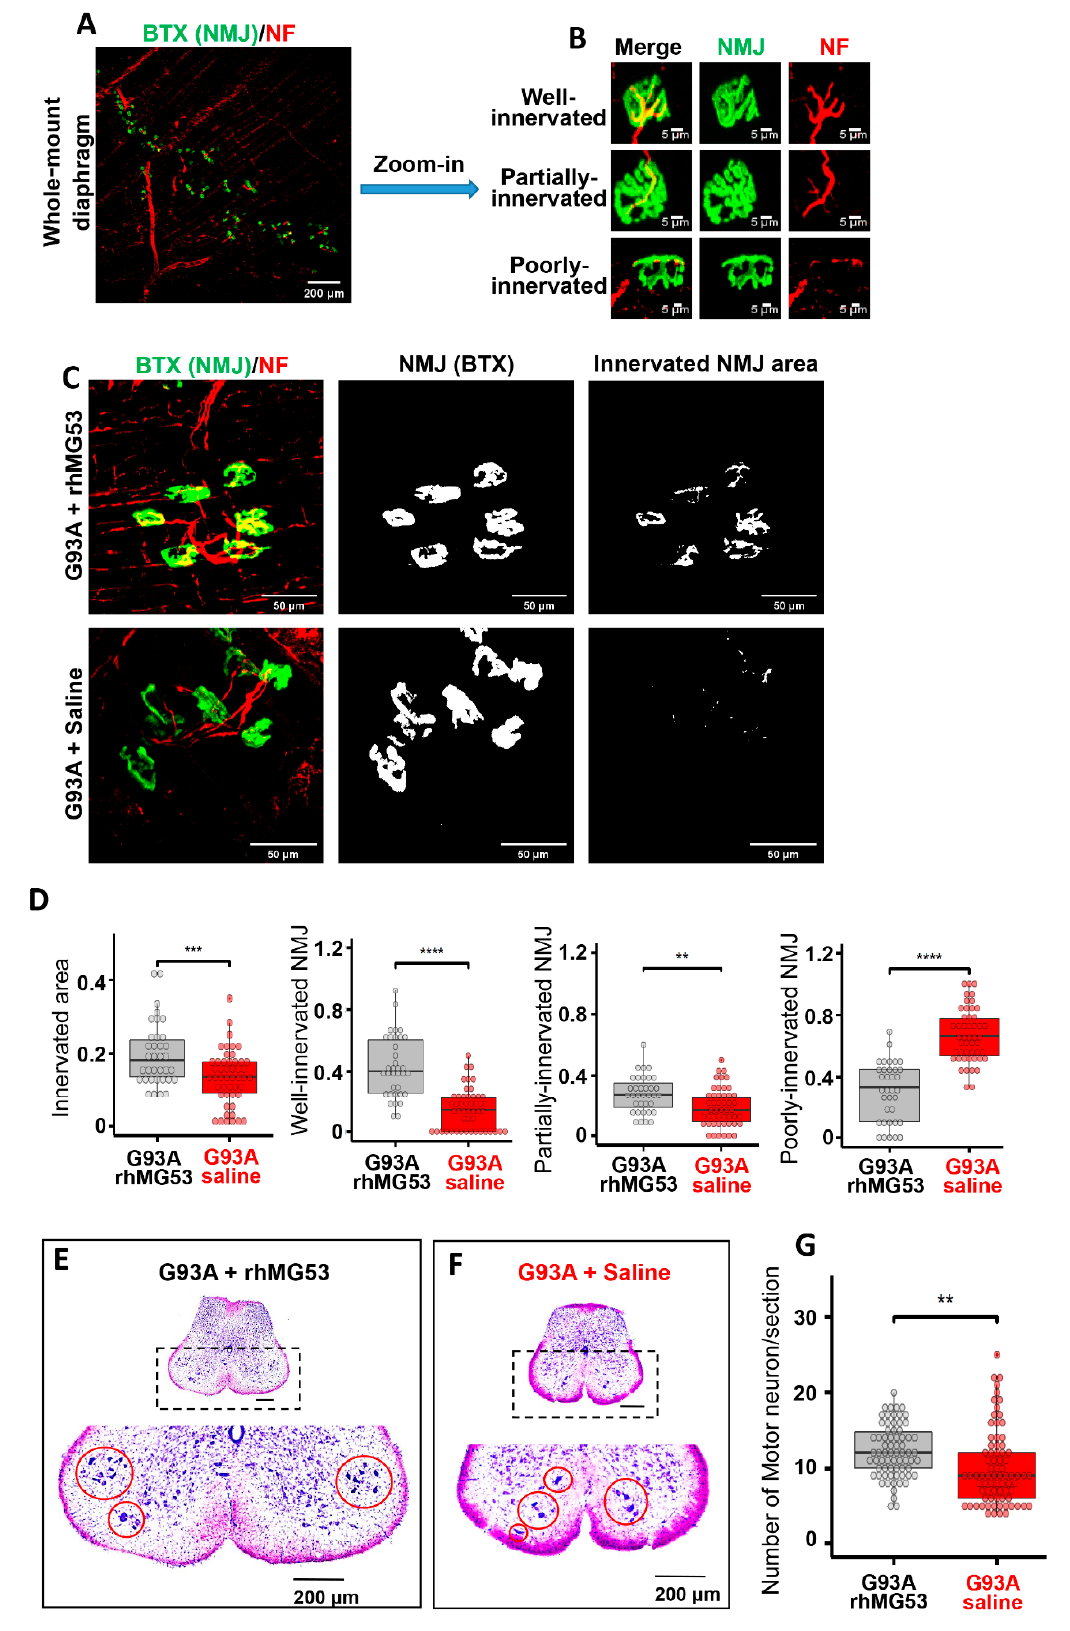
Figure 7. Systemic application of rhMG53 preserved NMJ integrity and promoted motor neuron survival in ALS mice. ( A ) Whole-mount fixed diaphragm muscle stained with the NF antibody (red) for marking axonal terminals and BTX